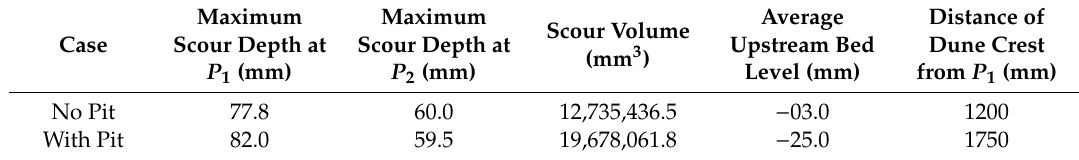
Figure 9. Snapshots showing the morphology around the tandem piers at the end of the experimental run for ( a ) no pit and ( b ) with pit cases. Table 2. Statistics of the morphological